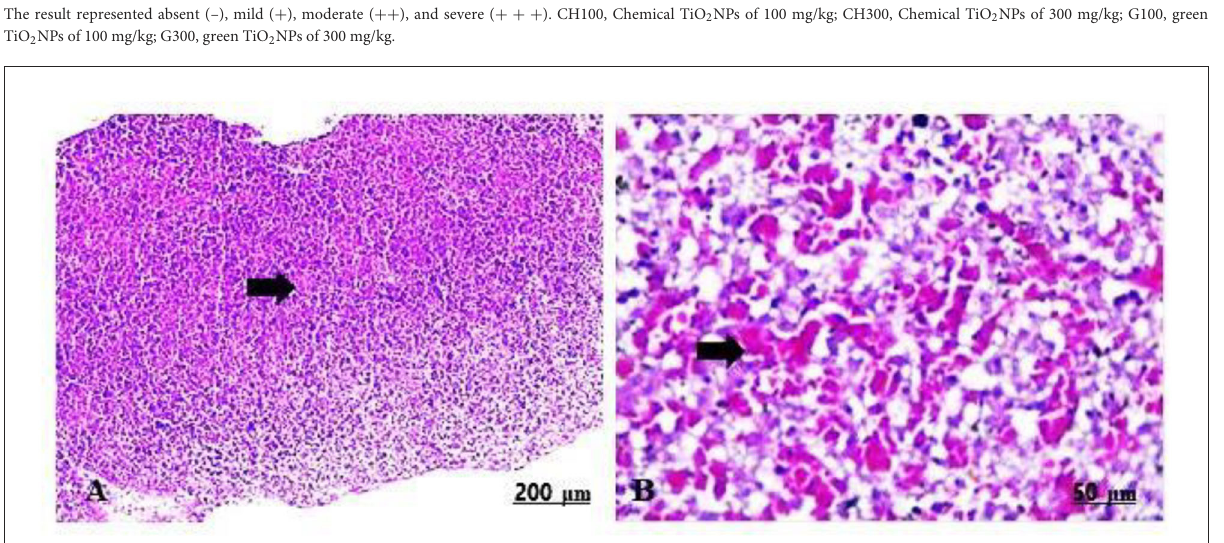
necrosis and cytoplasmic vacuolization of the hepatocytes with inflammatory cell infiltration (Table 5, Figure